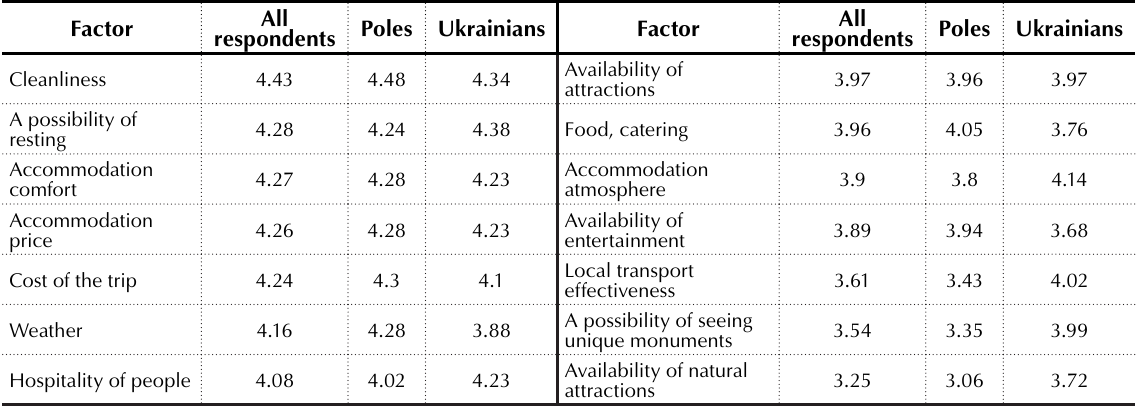
Table 6. Assessment of factors impacting on the satisfaction with the trip